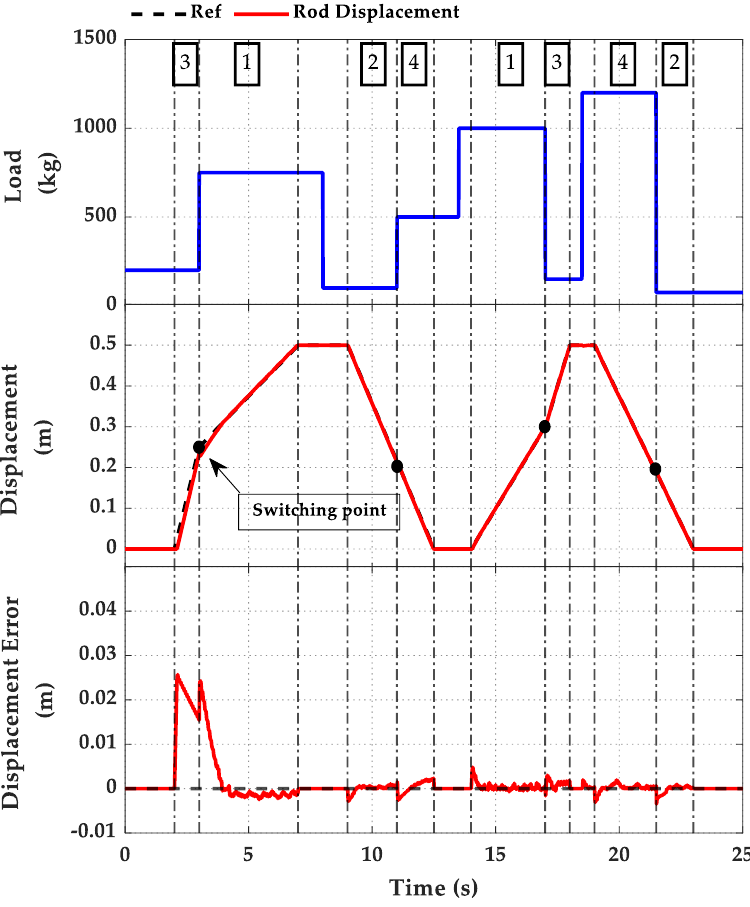
Figure 15. The switch mode during operating. (1) PE mode, (2) PR mode, (3) HSRE mode, and (4) LSRR mode.